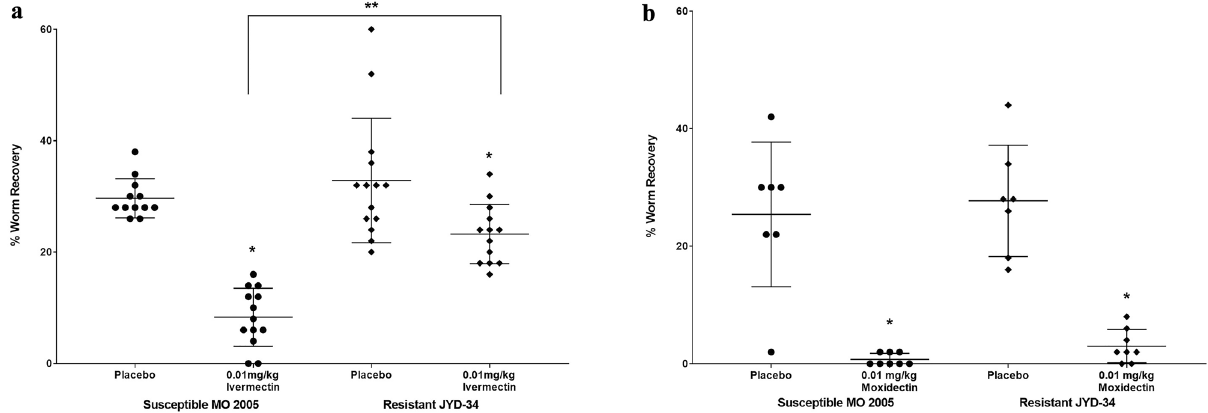
Figure 6. Effect of ivermectin and moxidectin on susceptible and resistant isolates of D. immitis in NSG mice. NSG mice were infected for 6 weeks with either the ML-susceptible MO 2005 isolate or the ML-resistant JYD- 34 isolate and treated on Day 0, 15 and 30 with ( a ) 0.01 mg/kg of Ivermectin or ( b ) moxidectin. *Statistically significant difference, p value ≤ 0.05 between placebo and treated groups. **Statistically significant difference, p value ≤ 0.05 between treated susceptible and resistant